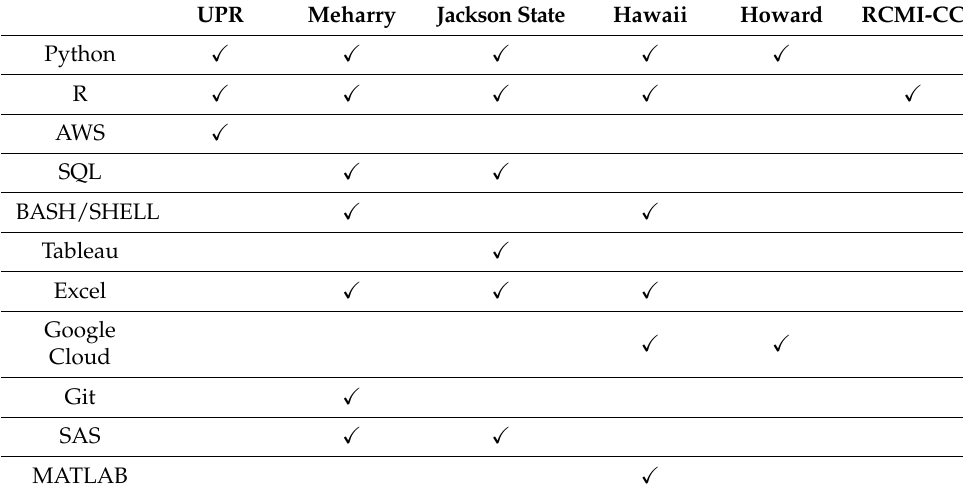
Table 4. Summary of curricular topics covered.